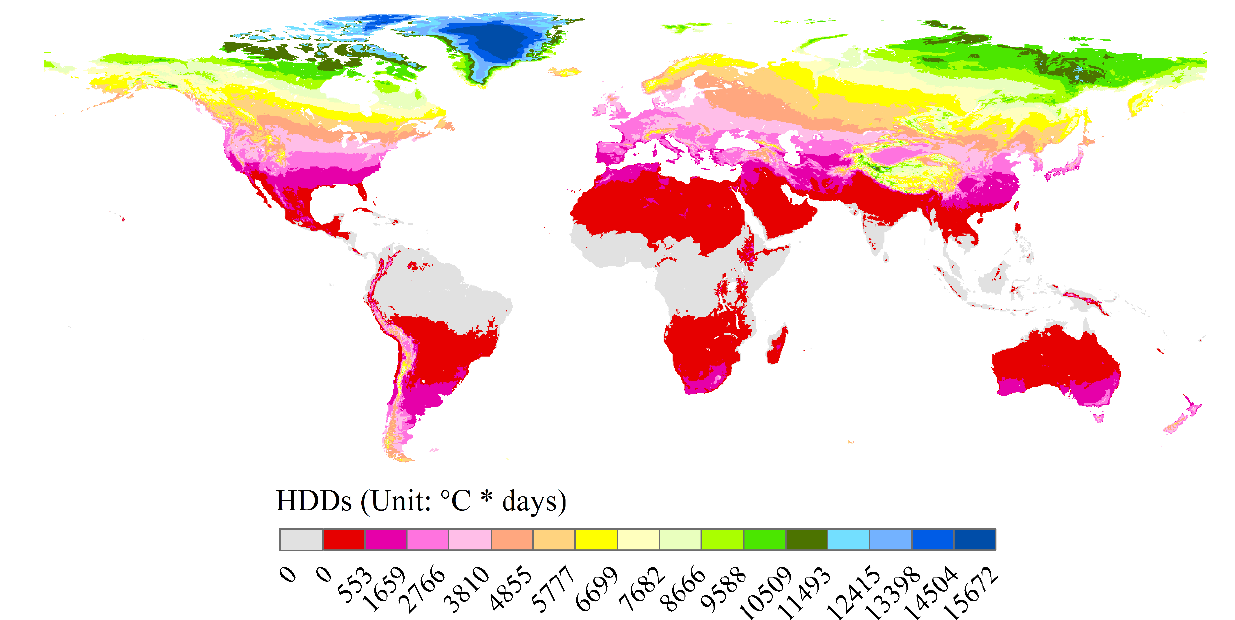
Figure 1. Distribution of global heating degree days between 2014 and 2018. The global Moran’s index for global five-year average HDDs was 0.988 at the 0.000 sig- nificant level. This indicated that high spatial positive correlations existed for global HDDs, and their values became more similar as the measured distance decreased. Moreover, both HH and LL clusters existed (Figure 2). The HH clusters mainly occurred in Greenland, northern Canada, northeastern Siberia, and some regions in Qinghai-Tibet Plateau and Sayan Mountains (a large upland area lying along the frontiers of east-central Russia and Mongolia). The LL clusters were mainly distributed in the southern United States, Central America, to vast majority of central South America, Africa, the Arabian peninsula, most of Iran, southwestern Afghanistan, south and southeast Asia, some of southern China, and the overwhelming majority of Australia.